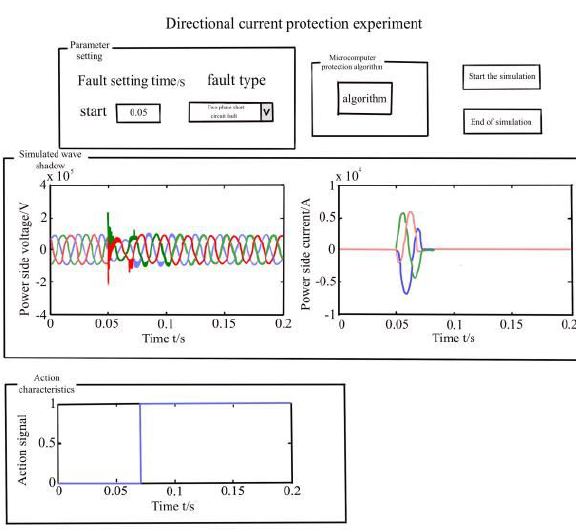
Figure 10: Voltage, current and action signals of power supply